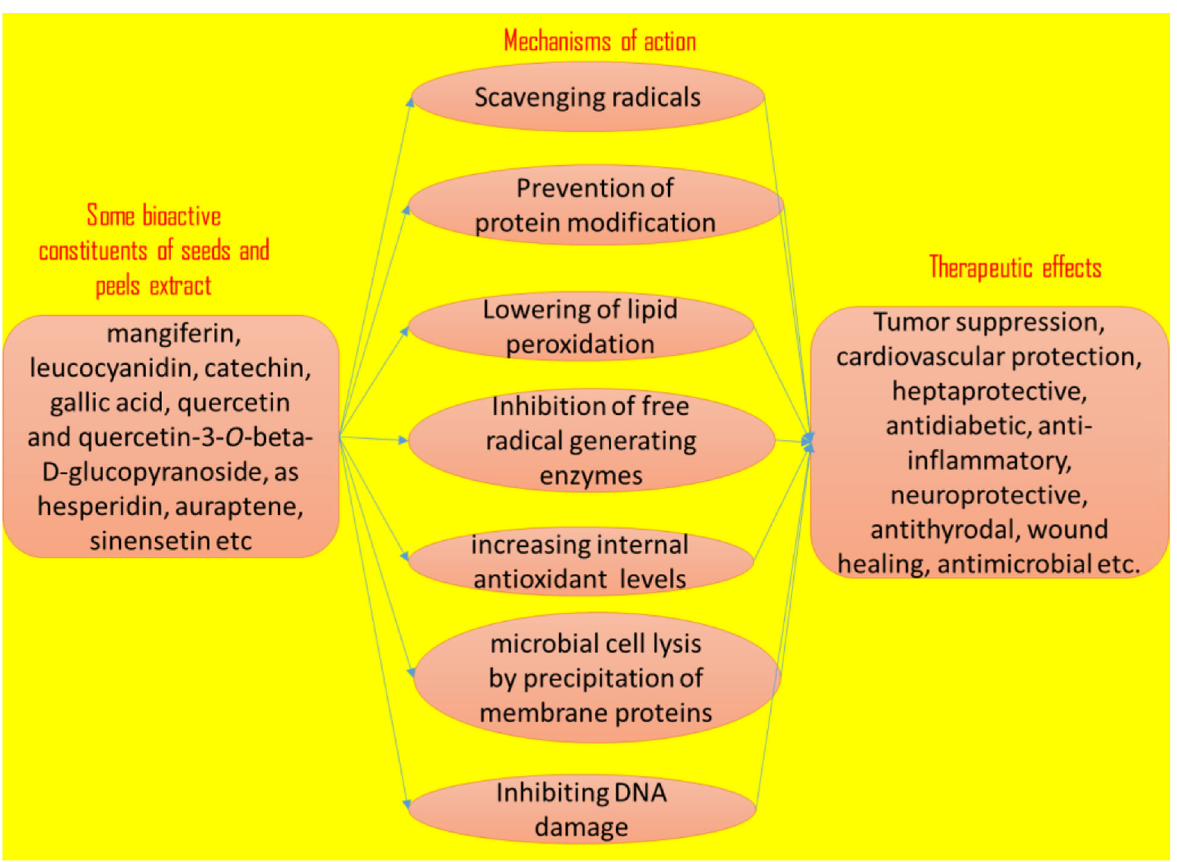
Fig. 2 Bioactive component of the peel and seed extract, their mechanisms of action and therapeutic